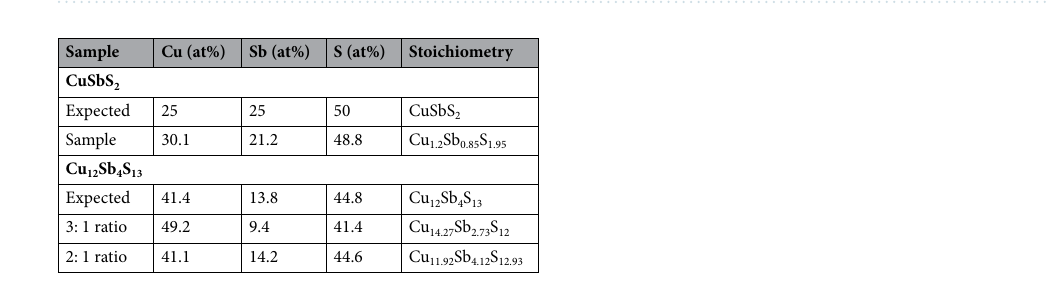
Figure 2. SEM images with different magnifications ( a , b ) for chalcostibite (CuSbS 2 ) and ( c , d ) for tetrahedrite (Cu 12 Sb 4 S 13 ).